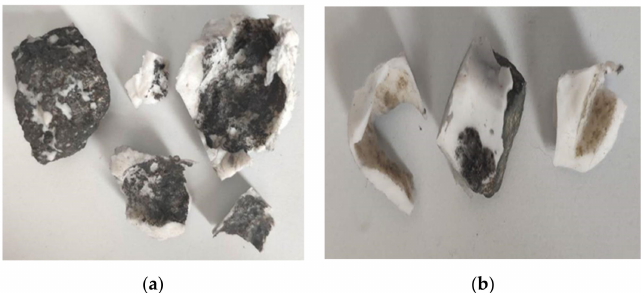
Figure 14. OSW and Stone after separating liquid silica gel. ( a ) OSW after separating liquid silica gel; ( b ) stone after separating liquid silica gel.